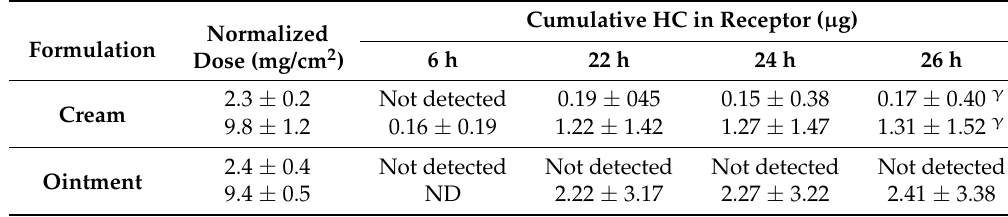
Table 3. Mean ( ± SD, n = 6) in vitro cumulative HC delivery across dermatomed porcine skin from thin (2 mg/cm 2 ) and thick (9 mg/cm 2 ) area-normalized doses of 1% HC cream and ointment. The transport area was 3.14 cm 2 . The superscript γ indicates significantly different values ( p <